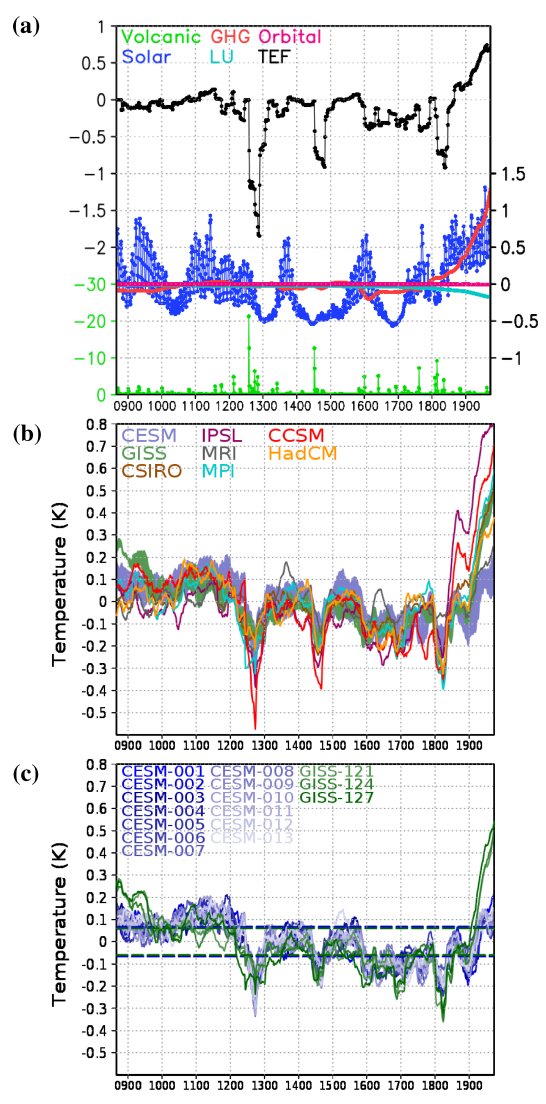
Figure 1. (a) External forcing factors (in Wm − 2 ) considered in the CESM-LME simulations, including greenhouse gases (GHGs), volcanic, solar, land use and cover (LU), and orbital forcing. The CESM-LME is selected as an example since it uses standard CMIP5/PMIP3 forcing specifications (Schmidt et al., 2011, 2012). The forcing related to greenhouse gases is obtained by aggregating the contributions of CO 2 , CH 4 , and N 2 O. Volcanic forcing is rep- resented with a different scale (in green). An evaluation of the total external forcing (TEF) following Fernández-Donado et al. (2013) is also included. (b) Global average of temperature in the ensemble of simulations. For CESM and GISS, the range of minimum and max- imum values in the subensemble at each time step is shown instead of individual model simulations. All temperature and TEF series have been 31-year low-pass filtered with a centered moving aver- age. (c) Individual simulations in CESM and GISS subensembles. Dashed blue (CESM) and green (GISS) lines represent the range ( x ± 2 SD) of the differences between each 31-year low-pass fil- tered member and the ensemble mean with x being the mean of the residual and SD the standard